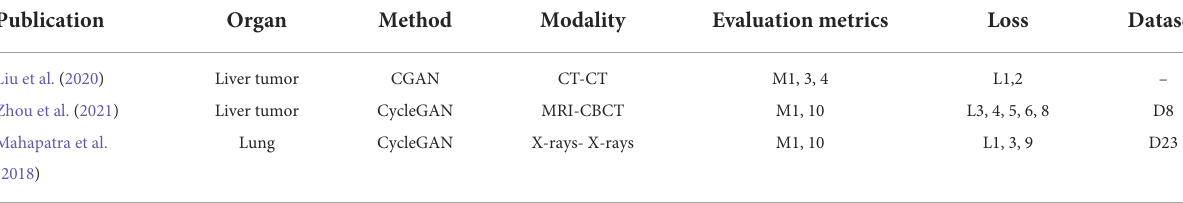
TABLE 5 Joint learning-based methods and